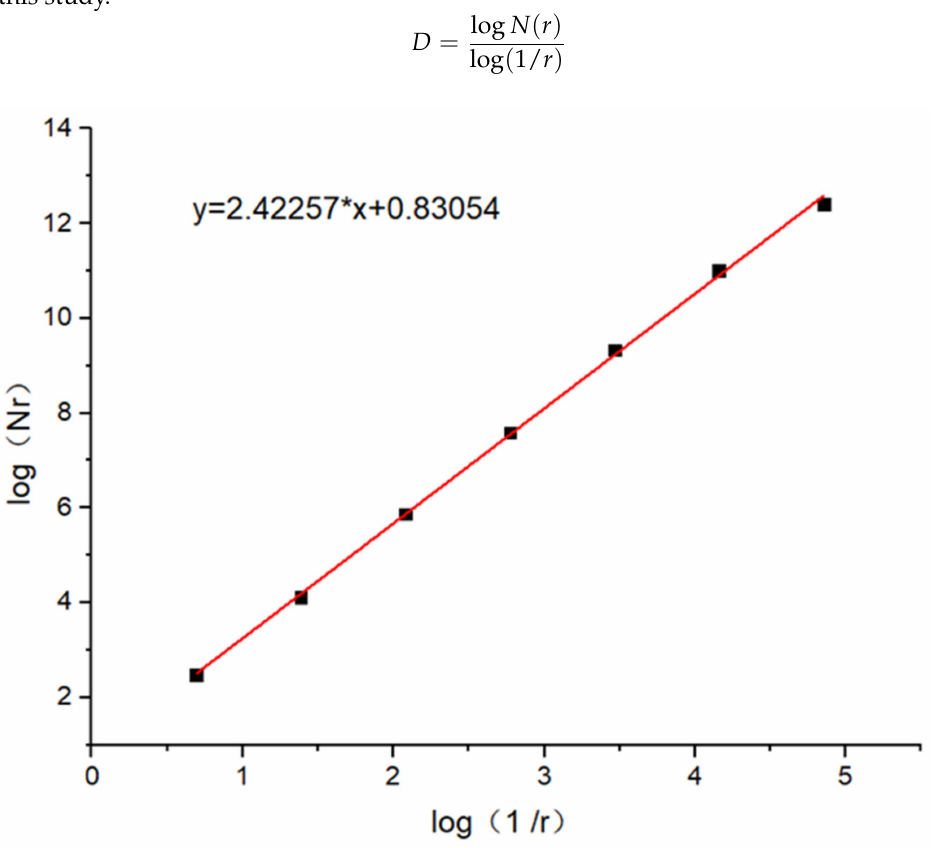
Figure 6. Fractal dimension of specimen